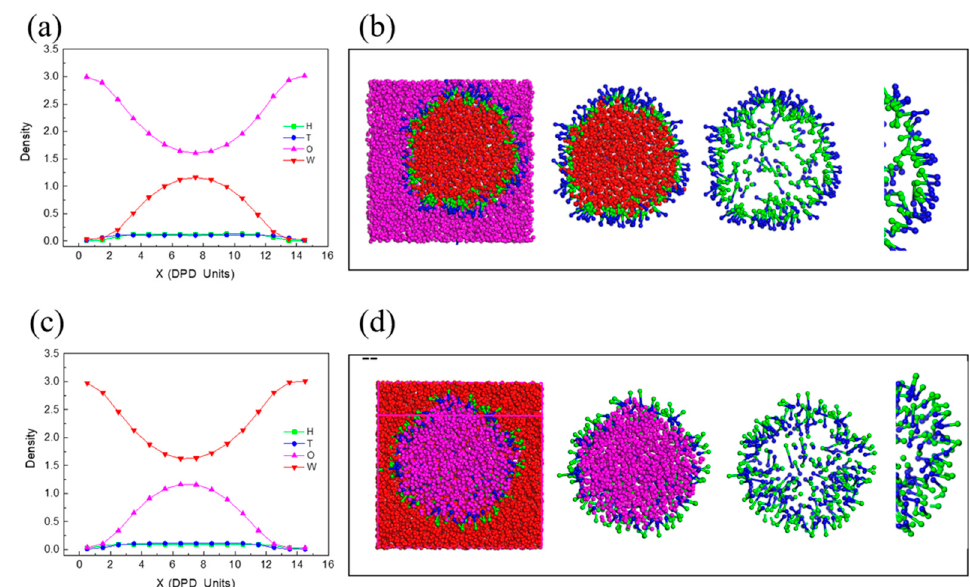
Figure 5. The density distribution of beads (H, T, W, O) along the x -axis in different oil-water ratios corresponding the translucent three-dimensional structures: ( a , b ) O/W = 3/1, ( c , d ) O/W = 1/3.